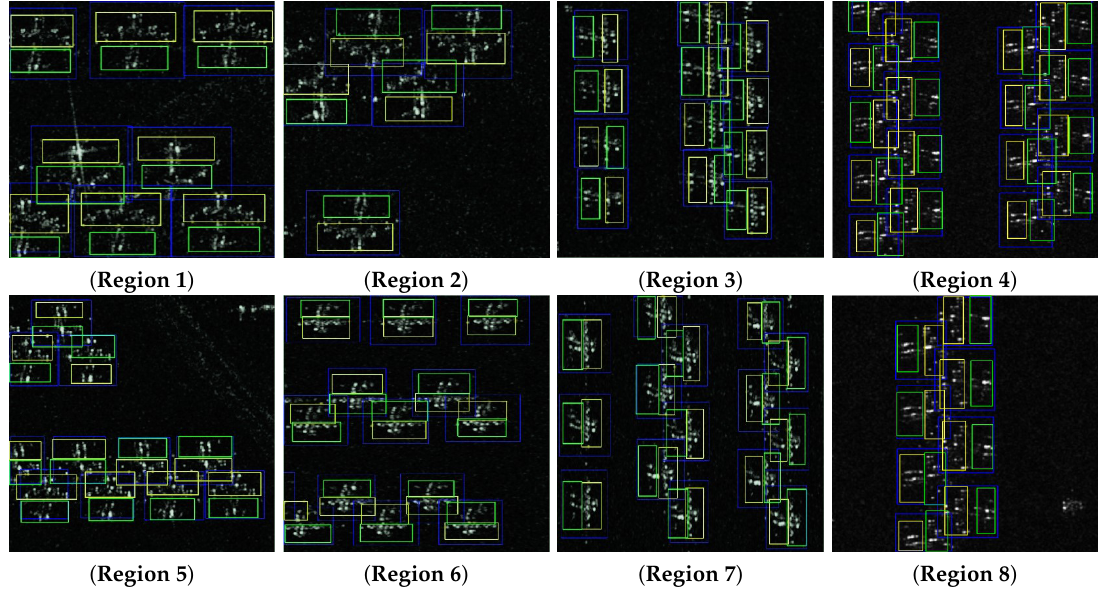
Figure 7. Detection results of the newly trained